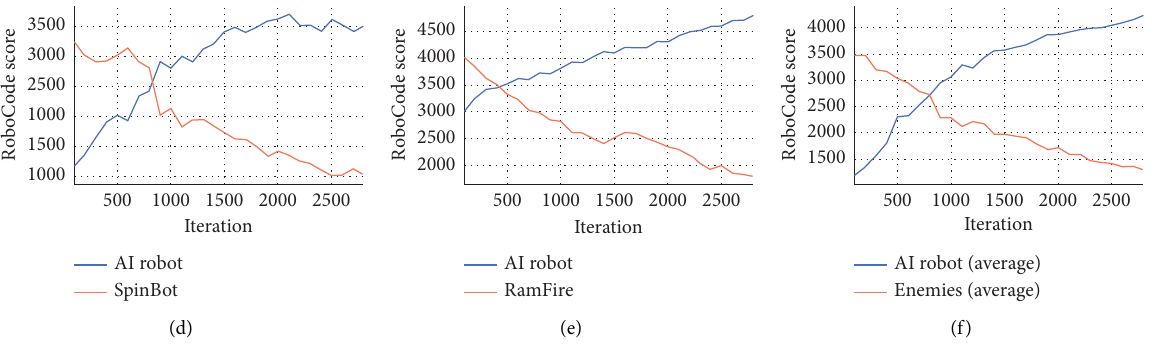
Figure 9: Training phase (against advanced predefined RoboCode robots).